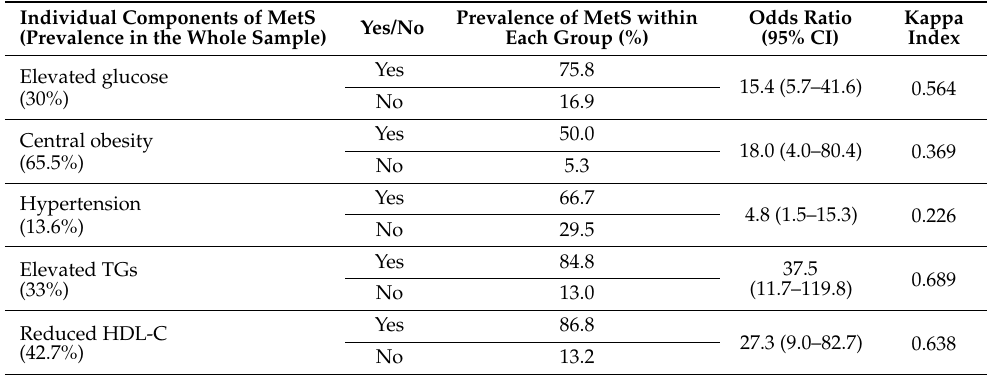
Table 5. Odds ratios of individual components of MetS to develop MetS by the NCEP-ATP III